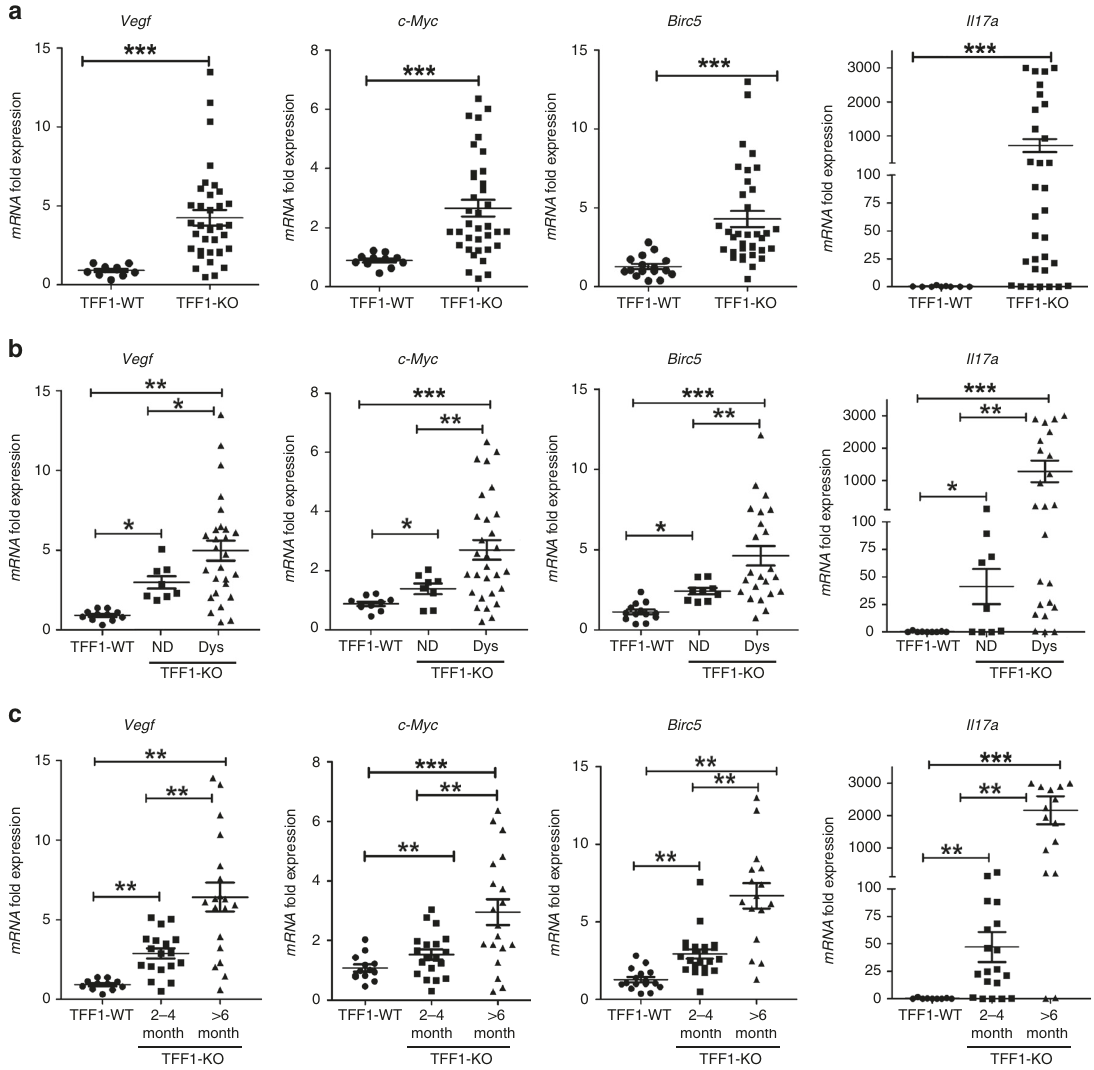
Fig. 2 Loss of TFF1 promotes mRNA expression of STAT3 target genes in gastric tumourigenesis. a Quantitative real-time PCR analysis demonstrated upregulation of mRNA expression of STAT3 target genes ( Vegf , c-Myc , Birc5 , and Il17A ) in gastric tissues from the TFF1-KO mice ( n = 36) as compared with normal gastric tissues from TFF1-WT mice ( n = 15). b Expression levels of STAT3 target genes in nondysplastic and dysplastic gastric mucosa from TFF1-KO, as compared to normal gastric mucosa from TFF1 - WT. c Expression levels of STAT3 target genes in TFF1-KO gastric mucosa at 2 – 4 and >6 months of age, as compared to age-matched TFF1- WT gastric mucosa. Horizontal bars indicate the mean values. * P < 0.05, ** P < 0.01 and *** P <